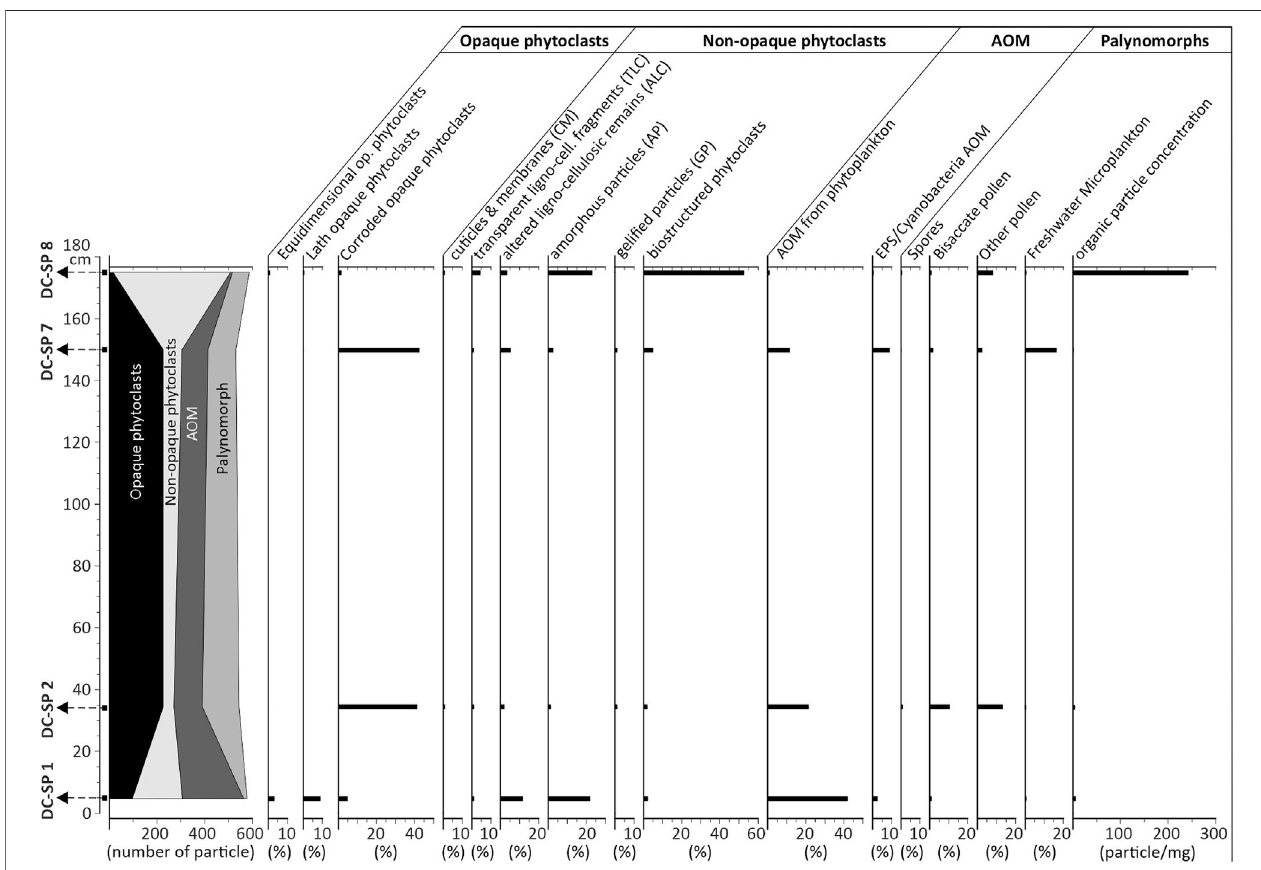
FIGURE 6 | Organic matter (OM) percentage abundance diagram for the DC-SP pro fi le in the Lower Cerova ˇ cka Cave. Diagram was made with the Tilia software (Grimm, 1991).